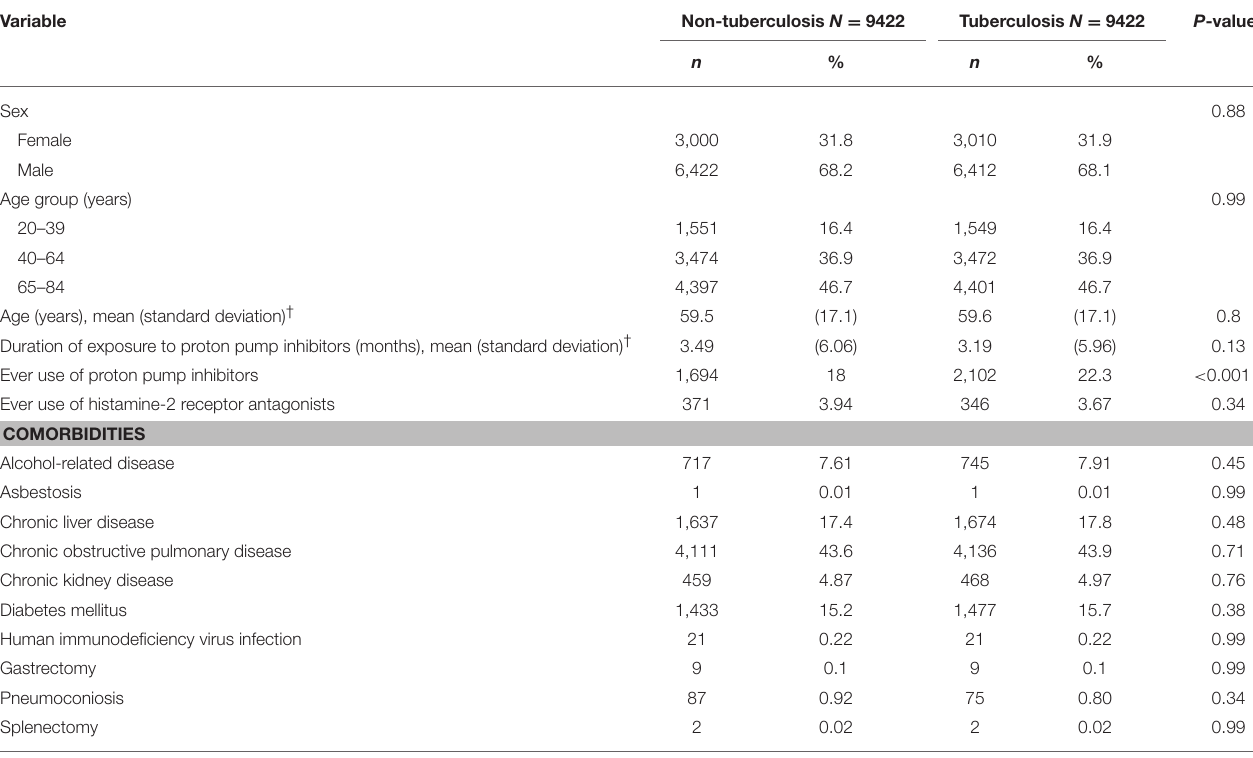
TABLE 1 | Information and comorbidities between pulmonary tuberculosis cases and controls.